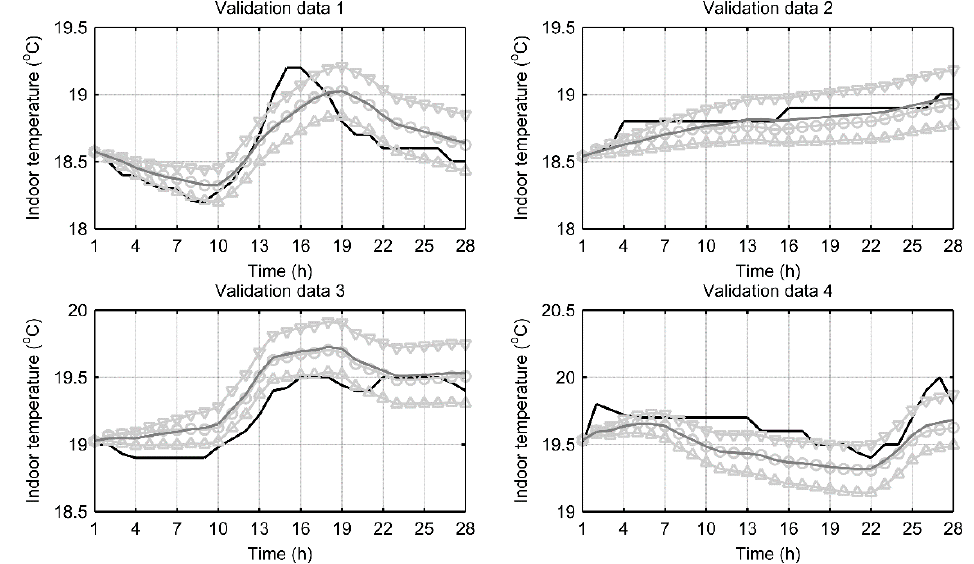
Figure 7. Sensitivity analysis of the indoor temperature prediction with simulated bias to the weather forecast in case of the model structure P1P3 with measured data from building A and four validation data sets. Black line is the measured indoor temperature and dark grey line is the indoor temperature prediction with measured outdoor temperature. Light grey line with circles is a representative example of the indoor temperature prediction with a normally distributed weather forecast. Light grey lines with upward and downward triangles are the simulated indoor temperature predictions using a weather forecast that contains a bias of 3 °C below or above the measured outdoor temperature respectively.